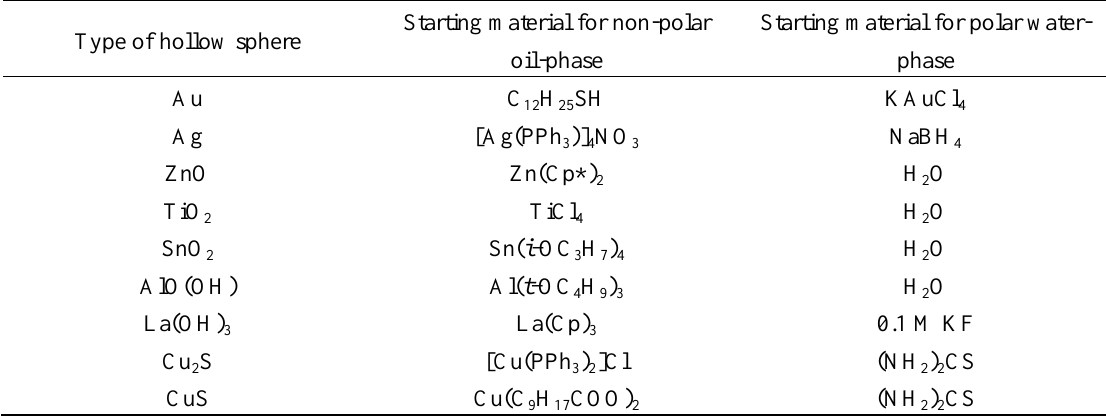
Table 1. Suitable starting materials for hollow sphere